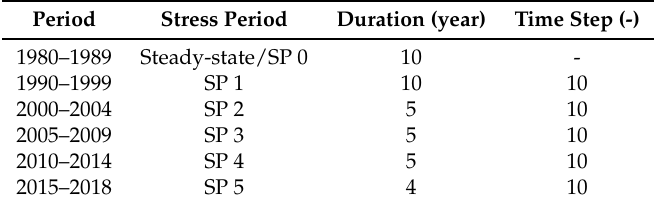
Table 1. Stress Period definition.